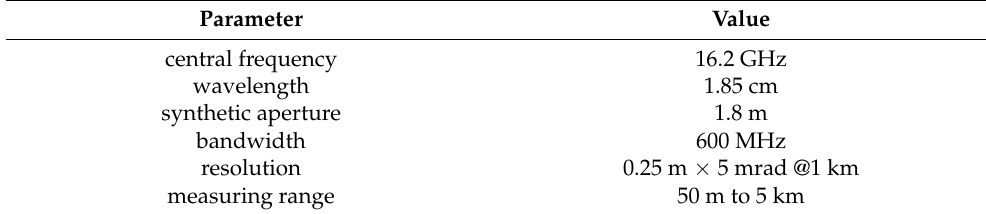
( b ) Figure 9. ( a ) Signal-to-noise ratio (SNR) map of the monitoring area; ( b ) ADI map calculated with the first 30 images.